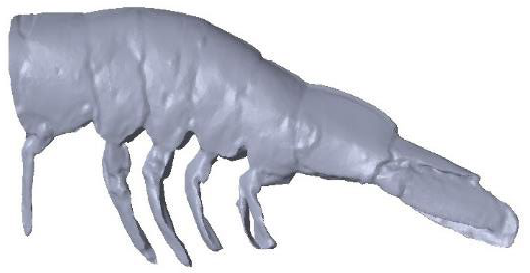
Figure 15. The 3D model of shrimp.